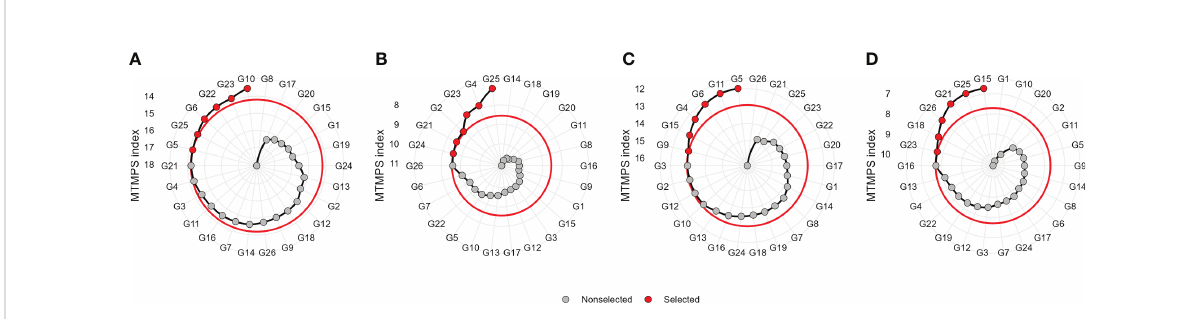
FIGURE 6 Genotype ranking and selected genotypes for the multi-trait mean performance and stability index (MTMPS) considering a selection intensity of 25% within ME1 (A) , ME2 (B) , ME3 (C) , and ME4 (D) . The red and black circles represent selected and unselected genotypes in their respective environments.